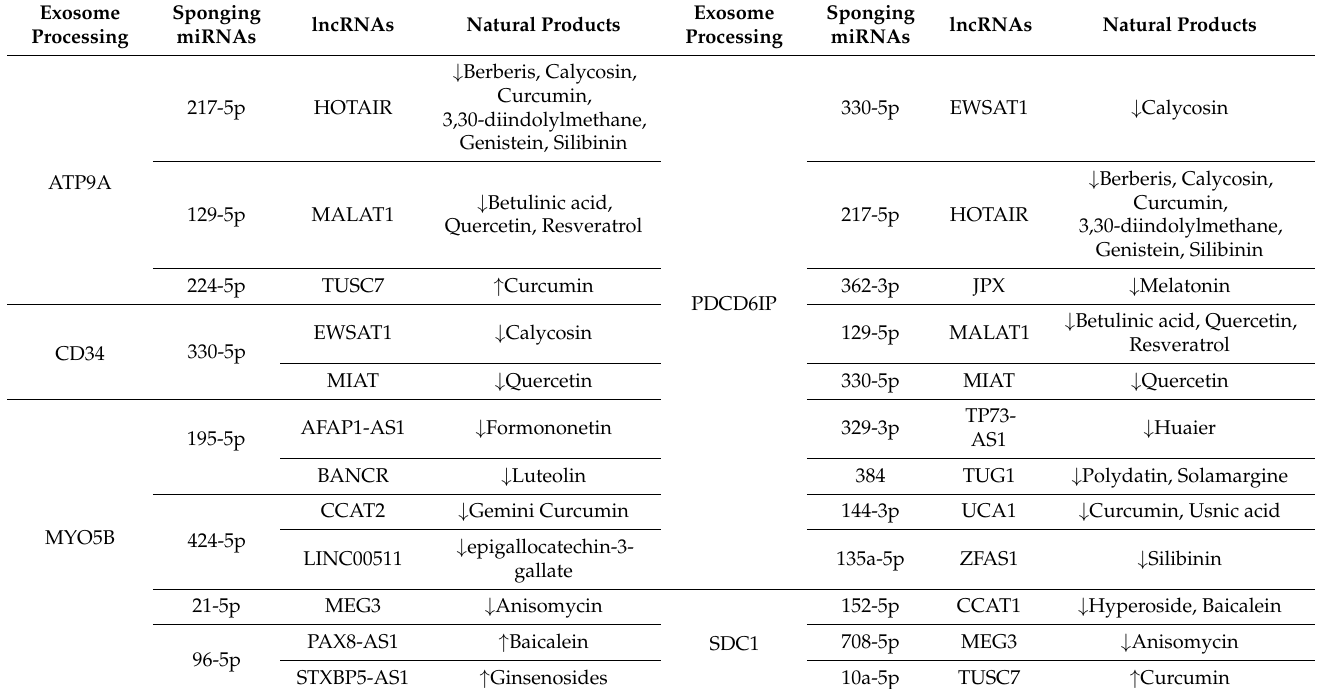
Table 4. Exosome-processing-target-centric view of predicted sponging miRNAs and natural-product- modulated